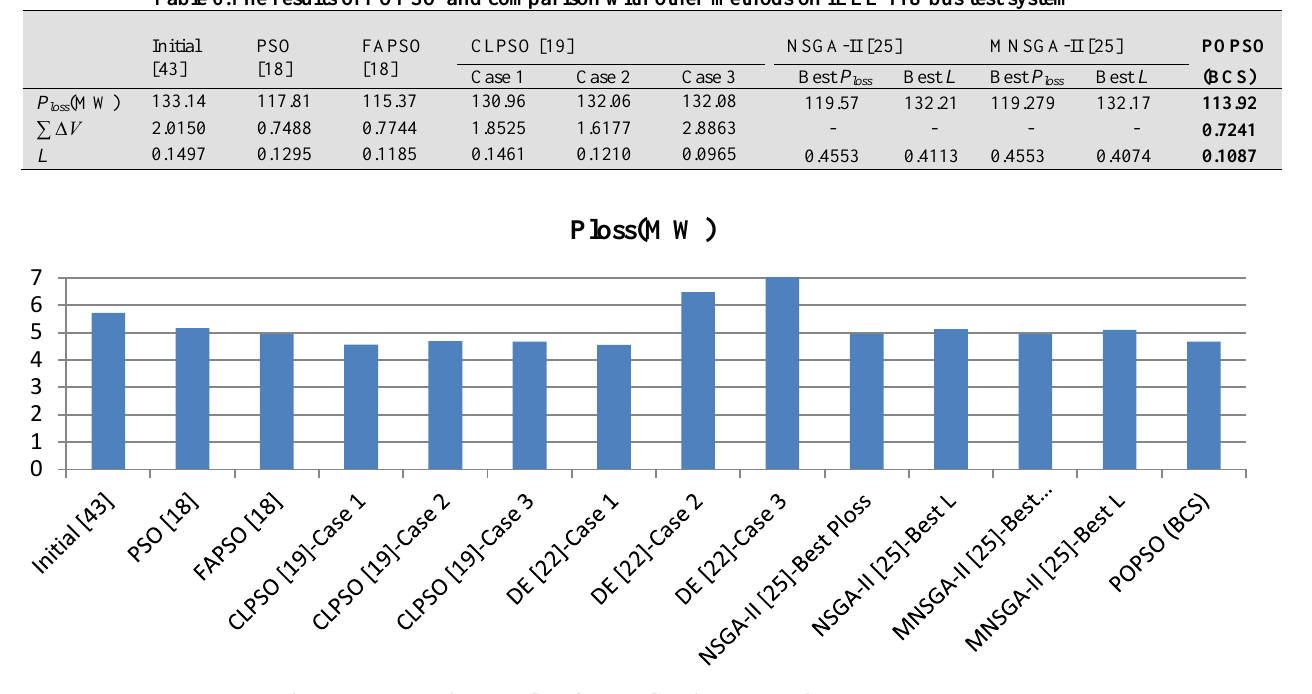
Figure 9. Comparison results of power loss in IEEE 30-bus test system